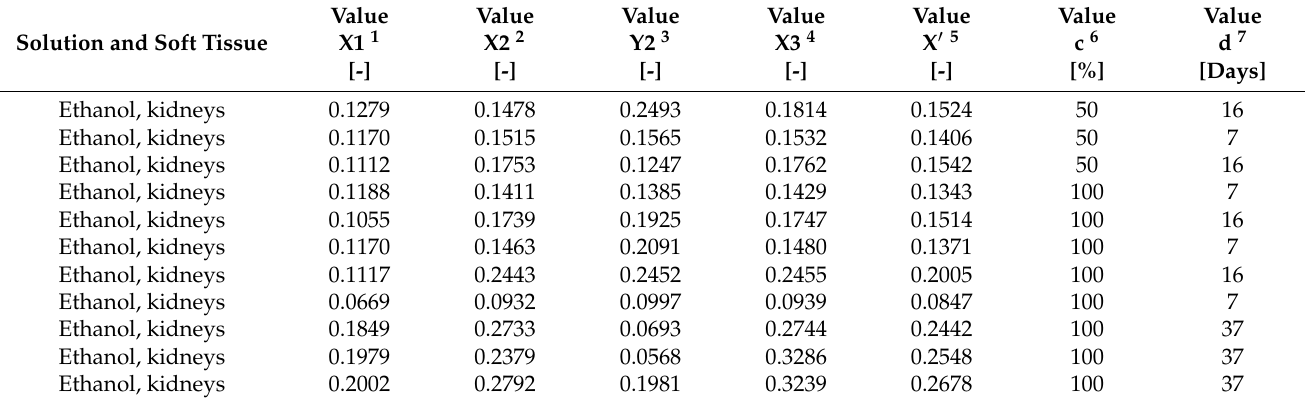
Table 3. Ethanol kidney raw data for centroid and Spearman ´ s correlation coefficient computation.